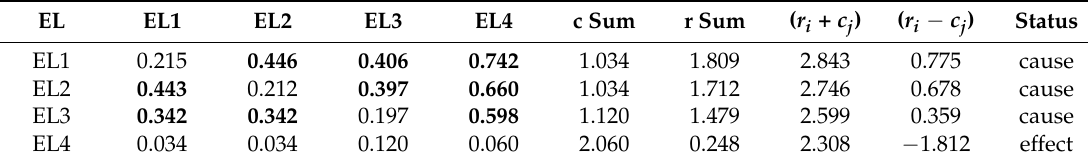
Table 8. The total relation matrix for electrical FMs.